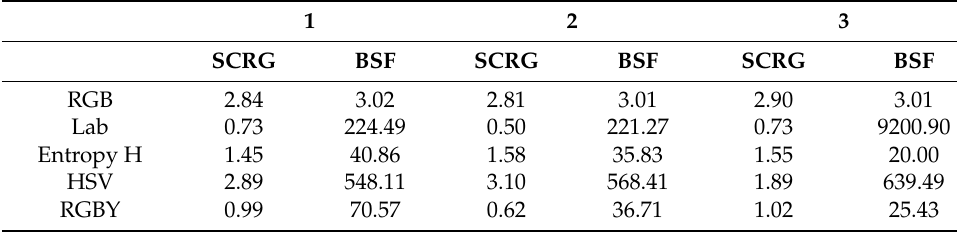
Table 2. Background suppression and noise immunity